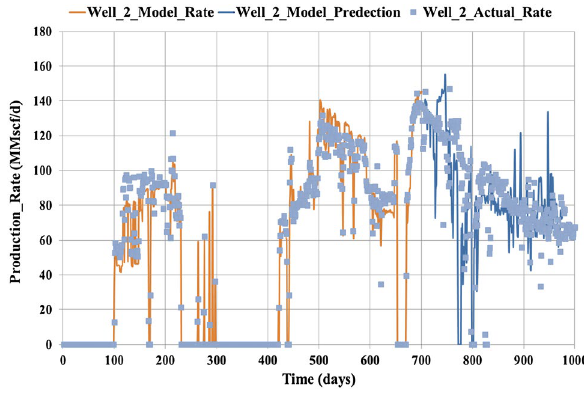
Fig. 5 Well 2 rate history match and prediction (case 1)